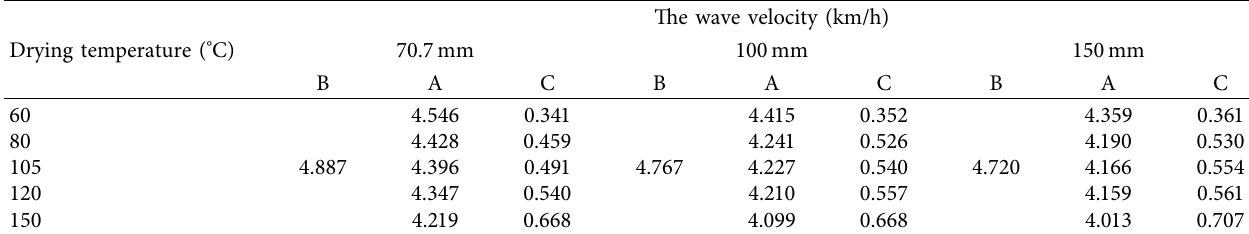
Table 3: The wave velocity of concrete with different sizes at different drying temperatures.